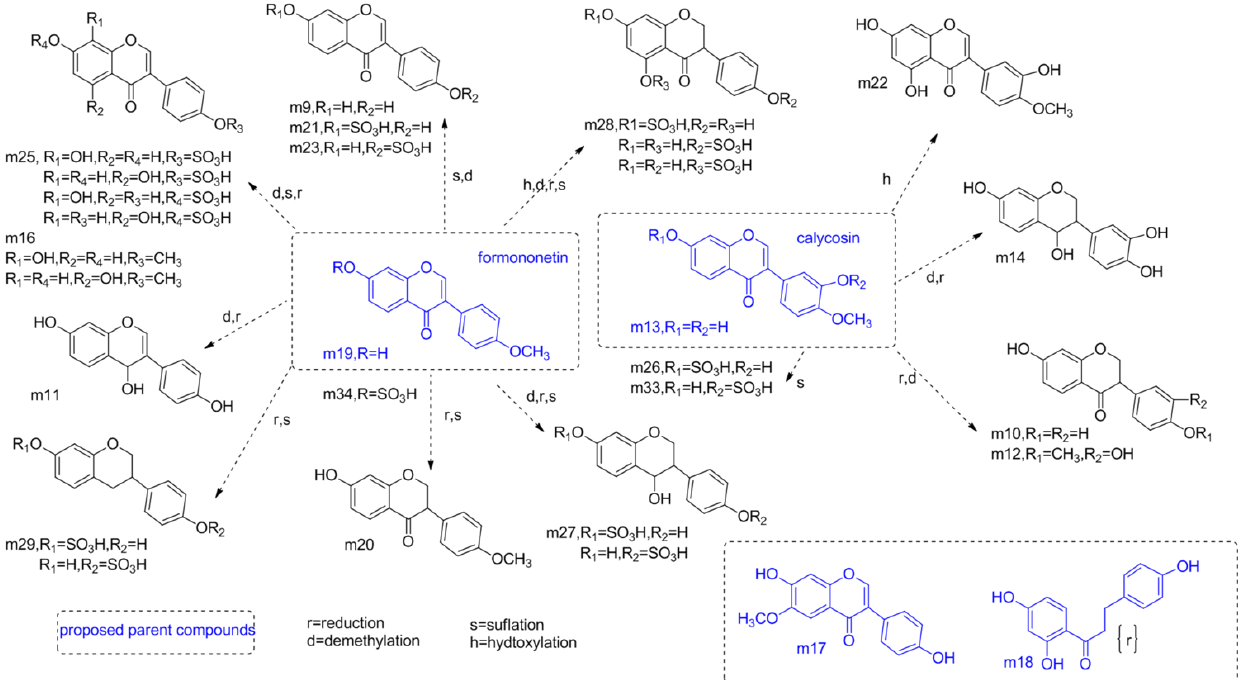
Figure 6. The main proposed metabolites identified from the urine samples of rats that had been administrated Danggui Buxue Tang